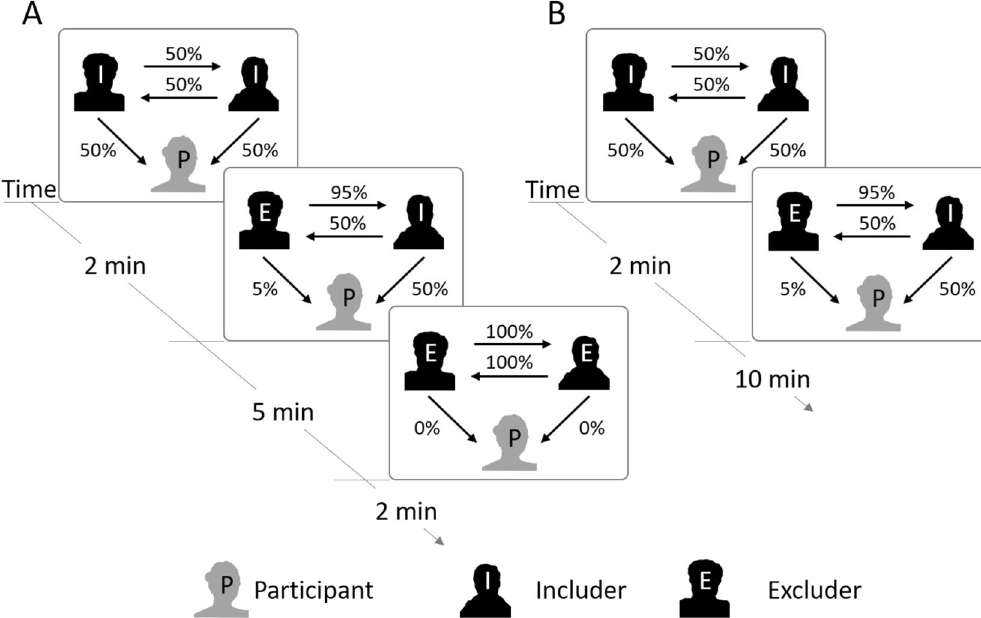
Figure 1. ( A ) Design of the modified Cyberball paradigm in experiment 1. Participants play two min social inclusion (baseline period; 50% ball tosses from both players), followed by five min partial exclusion (5% ball tosses from the excluding player and 50% ball tosses from the including player) and two min total exclusion (no ball tosses from both players). ( B ) Design of the modified Cyberball paradigm in experiment 2. Participants play two min social inclusion (baseline period; 50% ball tosses from both players), followed by 10 min partial exclusion (5% ball tosses from the excluding player and 50% ball tosses from the including player). Participants in the control condition (not presented here) play 12 min social inclusion (50% ball tosses from both